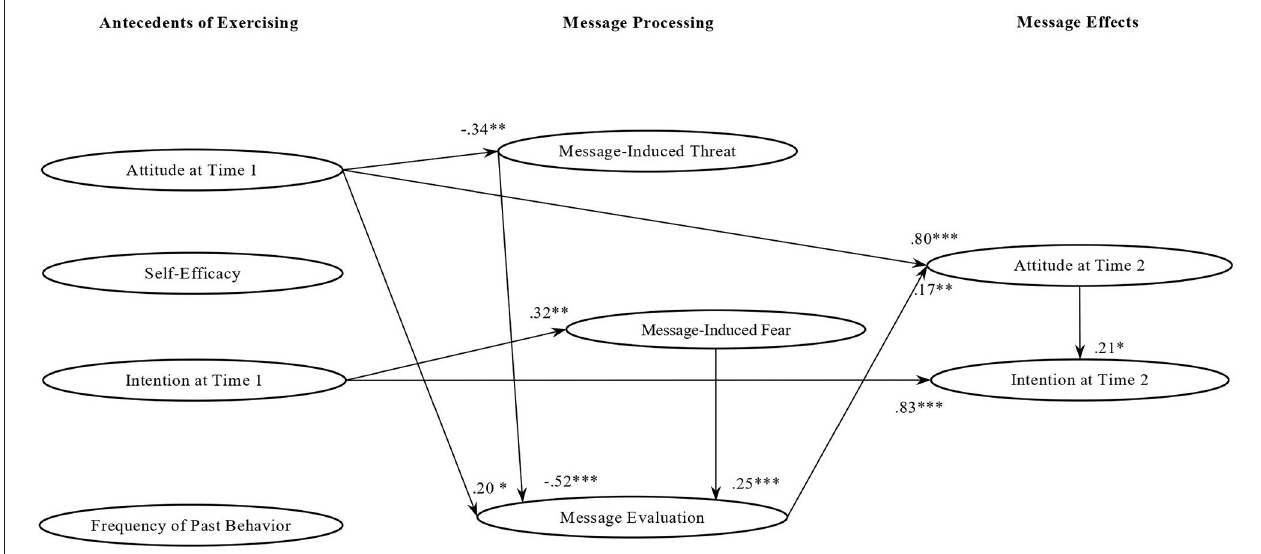
FIGURE 3 | Standardized factor loadings of the relationships among study variables in the non-gain message group. * p < 0.10; ** p < 0.05; *** p < 0.001.